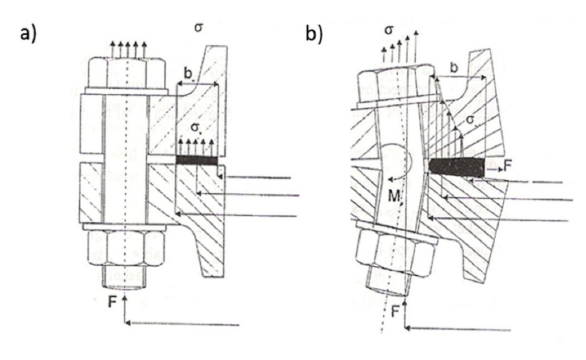
Figure 2: Stress distribution of the flange bolted joint a) perfectly stiffen flanges b) real stress distribution [5]